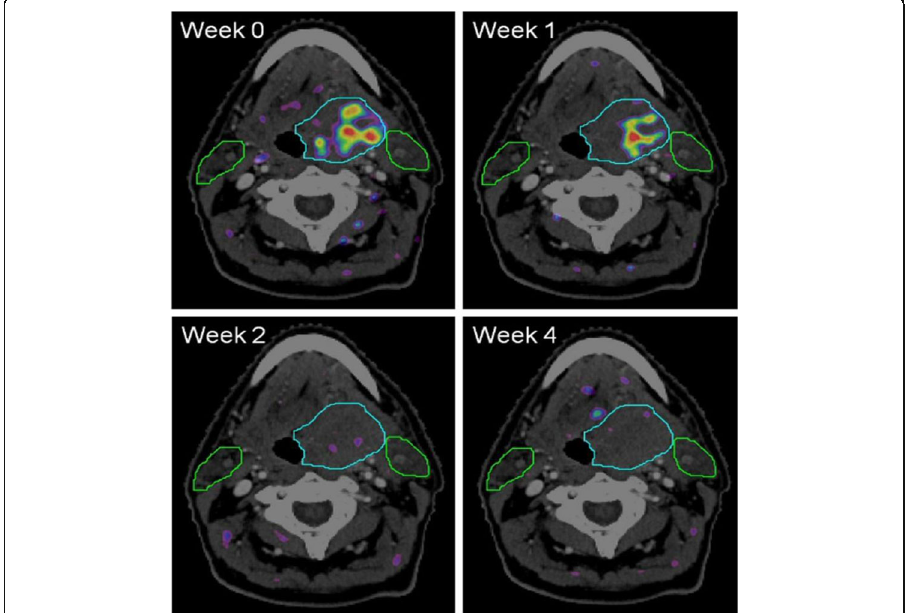
Fig. 68 18 F-FAZA, therapy evaluation of a brain lesion. PET/CT findings : four FAZA-PET-CT scans made at different weeks prior (week 0) and during (week 1, 2, and 4) the course of chemoradiation. The rainbow colours depict the amount of FAZA uptake. The light blue line depicts the extent of the primary tumour situated in the base of tongue. The green lines depict the extent of the parotid glands (left and right). Note that in week 2 and 4 no increased FAZA uptake is visible any more, demonstrating that the hypoxic area in week 0 and 1 disappeared